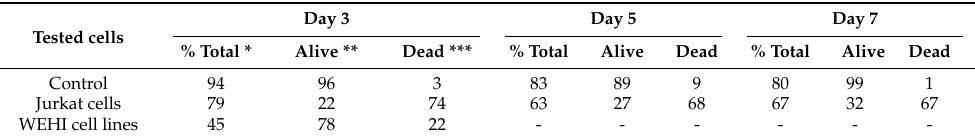
Table 2. Results of cell line studies.